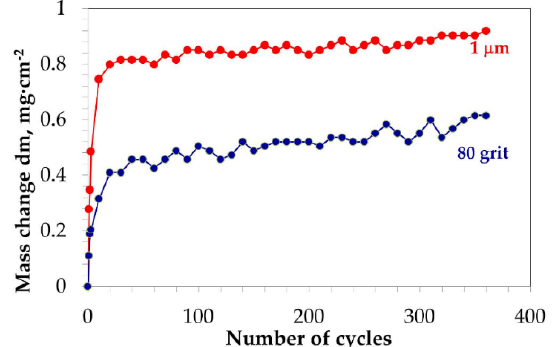
Figure 5. The mass change per unit area plots measured for polished and ground samples of Mar M 247 during rapid cyclic oxidation test. The cycles consisted of 2 h heating at 1000 °C and 15 min cooling with pressurized air.